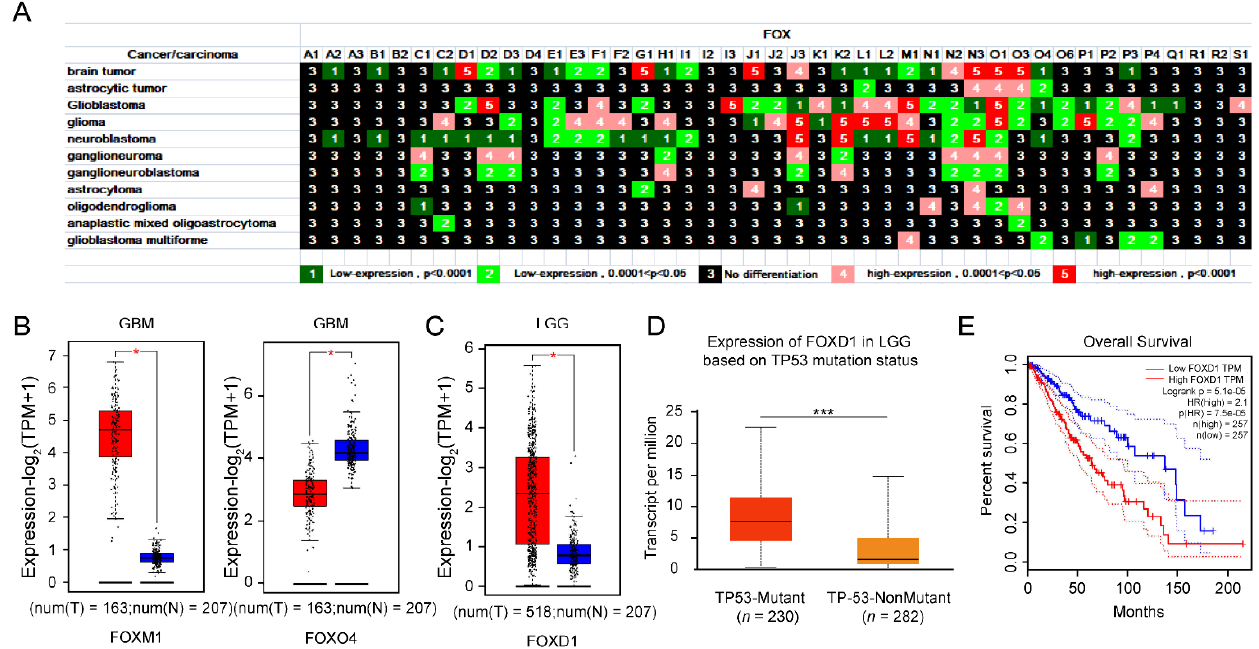
Figure 3. Differential expression of FOX genes in nervous system tumors ( A ). ( B ) The expression of FOXM1 and FOXO4 in GBM and normal tissues through GEPIA2. ( C ) The differential expression of FOXD1 between LGG and Normal groups. ( D ) The box plot of FOXD1 based on TP53 mutation statues in UALCAN-LGG dataset. ( E ) The survival curve of high and low expression groups for FOXD1 in LGG patients. p values less than 0.05 were considered to be statistically significant, * p < 0.05, *** p < 0.001.